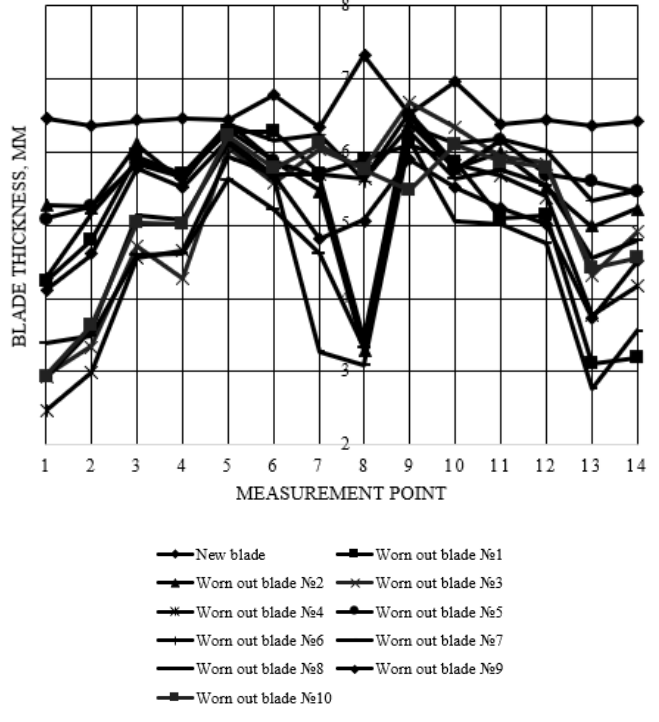
Fig. 6. Change in metal thickness of cultivator blades of 9.3 "TigerMate II made in Canada while operating (according to Fig. 3)